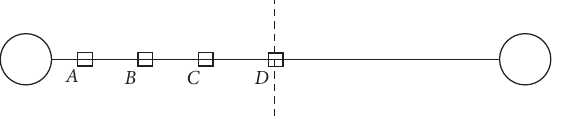
Figure 7: Measuring elements distribution on blastholes connecting.